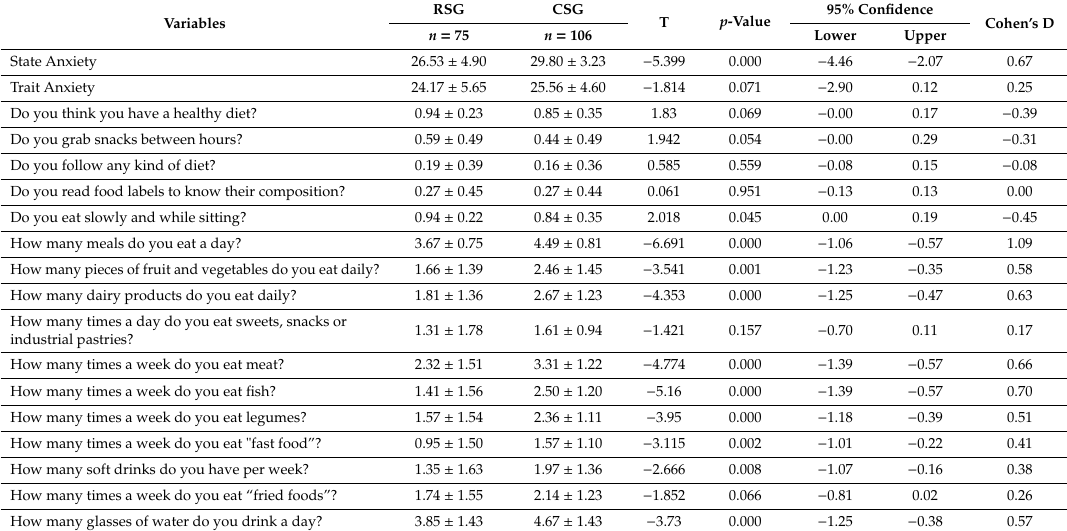
Table 3. Anxiety and nutritional information of rural and city school